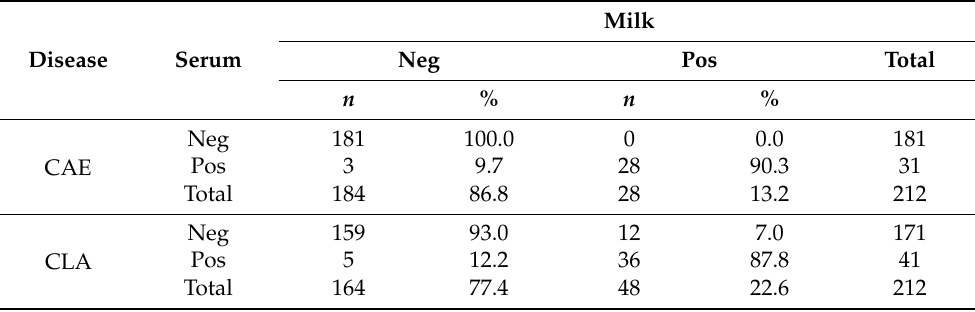
Figure 2. CLA-ELISA absorbance values in serum ( x -axis) vs. milk ( y -axis) in 212 lactating goats included in the study to estimate the occurrence of CAE and CLA (Sweden, 2018). Table 2. CAE and CLA ELISA test results in serum and milk from 212 lactating goats included in the study to estimate the occurrence of CAE and CLA (Sweden, 2018).